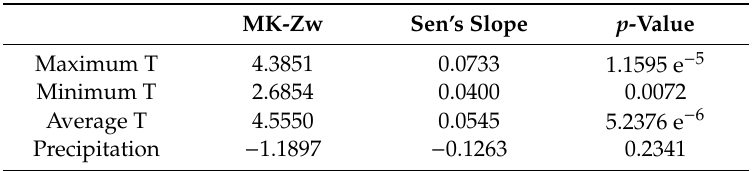
Table 2. Results of Mann-Kendall test and Sen’s slope analysis for the maximum, minimum and average temperatures and precipitation.